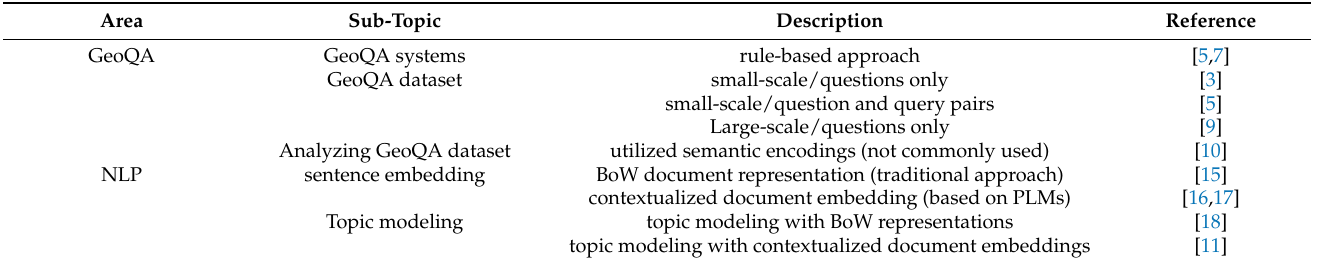
Table 3. Overview of related works. Our study contributes to the area of GeoQA, particularly in analyzing the GeoQA dataset by utilizing topic modeling methods with contextualized document embeddings recently proposed in the area of